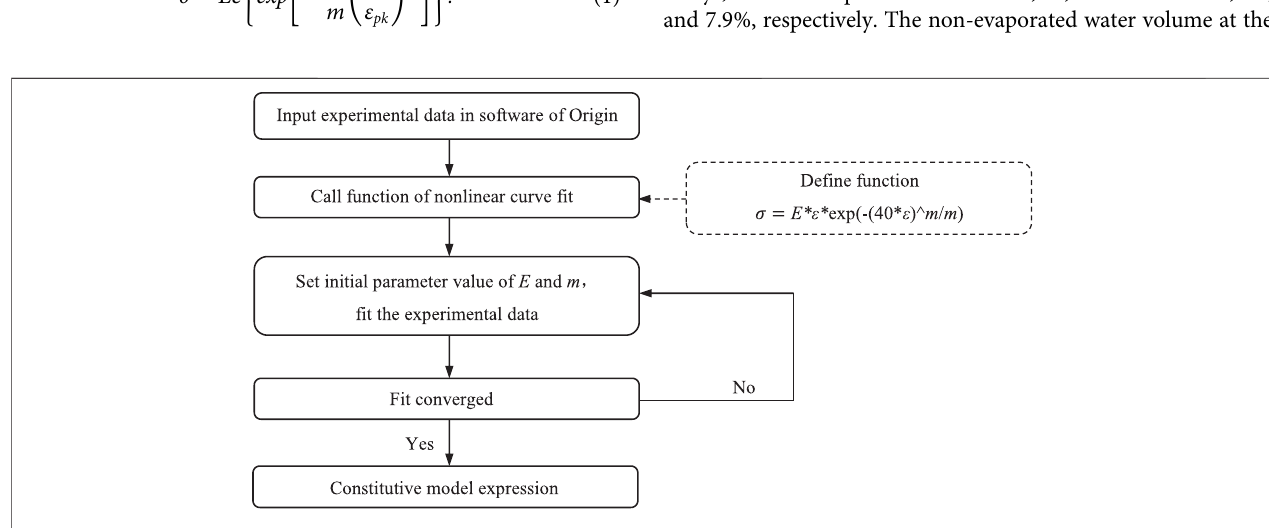
Figure 5 | Schematic diagram of the calculation procedure of the constitutive model.